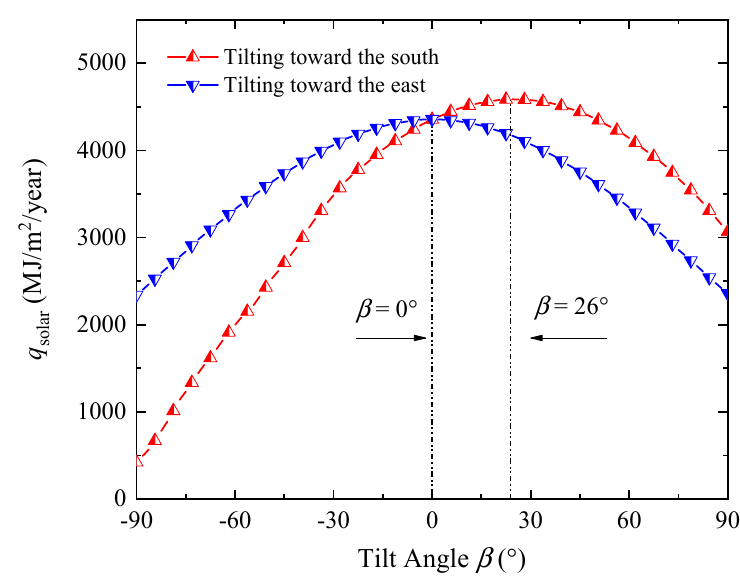
Figure 8. Annual solar radiation intensity at various tilt angles in Nanjing city.